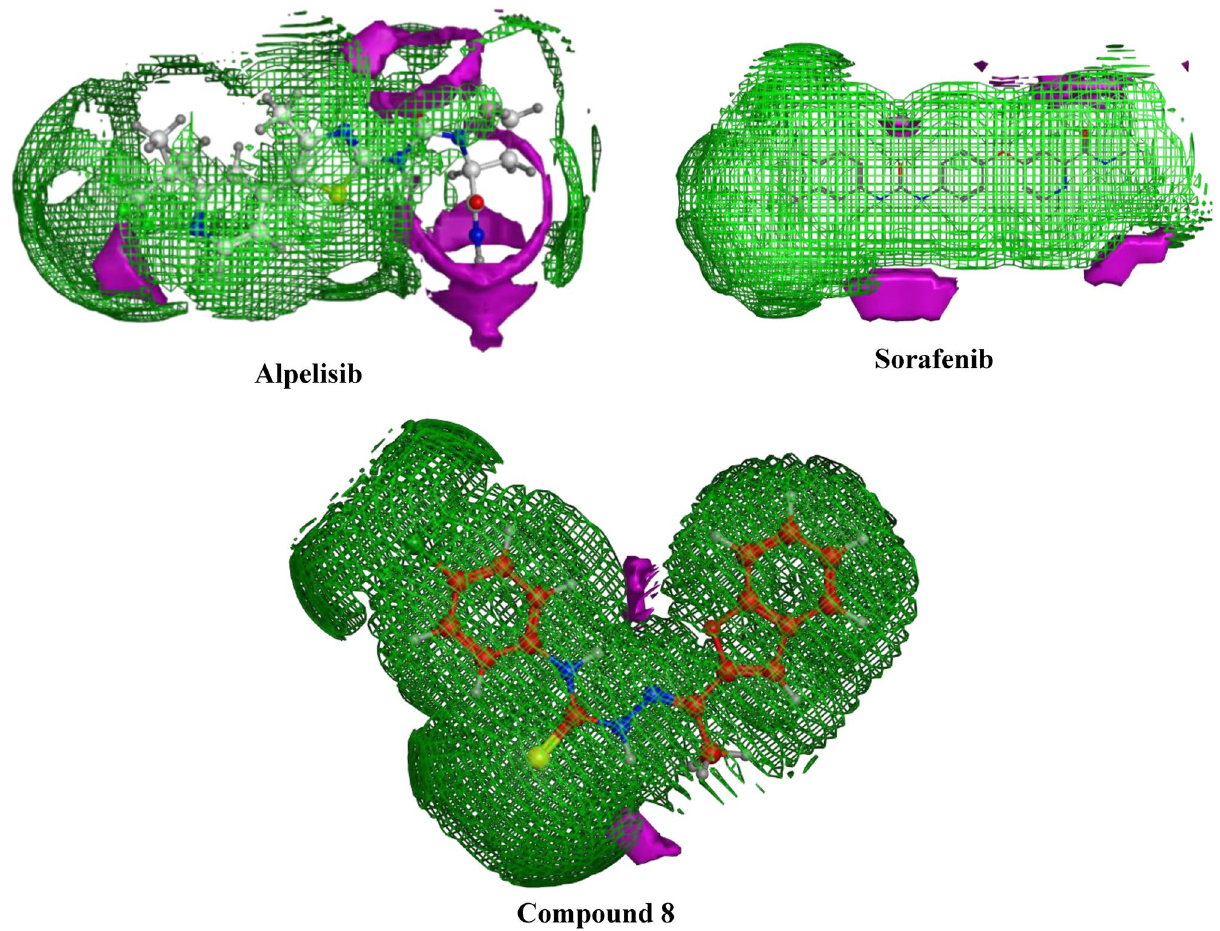
Figure 11. Contact preference for compound 8 and alpelisib. Hydrophobic: green, hydrophilic: red.